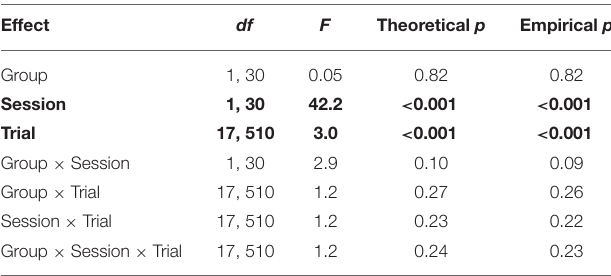
TABLE 2 | ANOVA of ITI drinking time (fear of context alone) during extinction